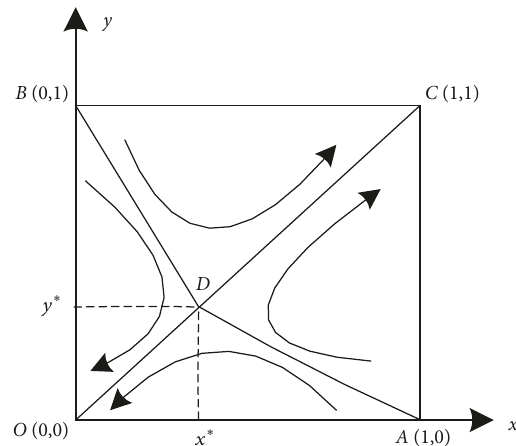
Figure1:Phasediagramforevolutionarysuppliers&manufacturers game.